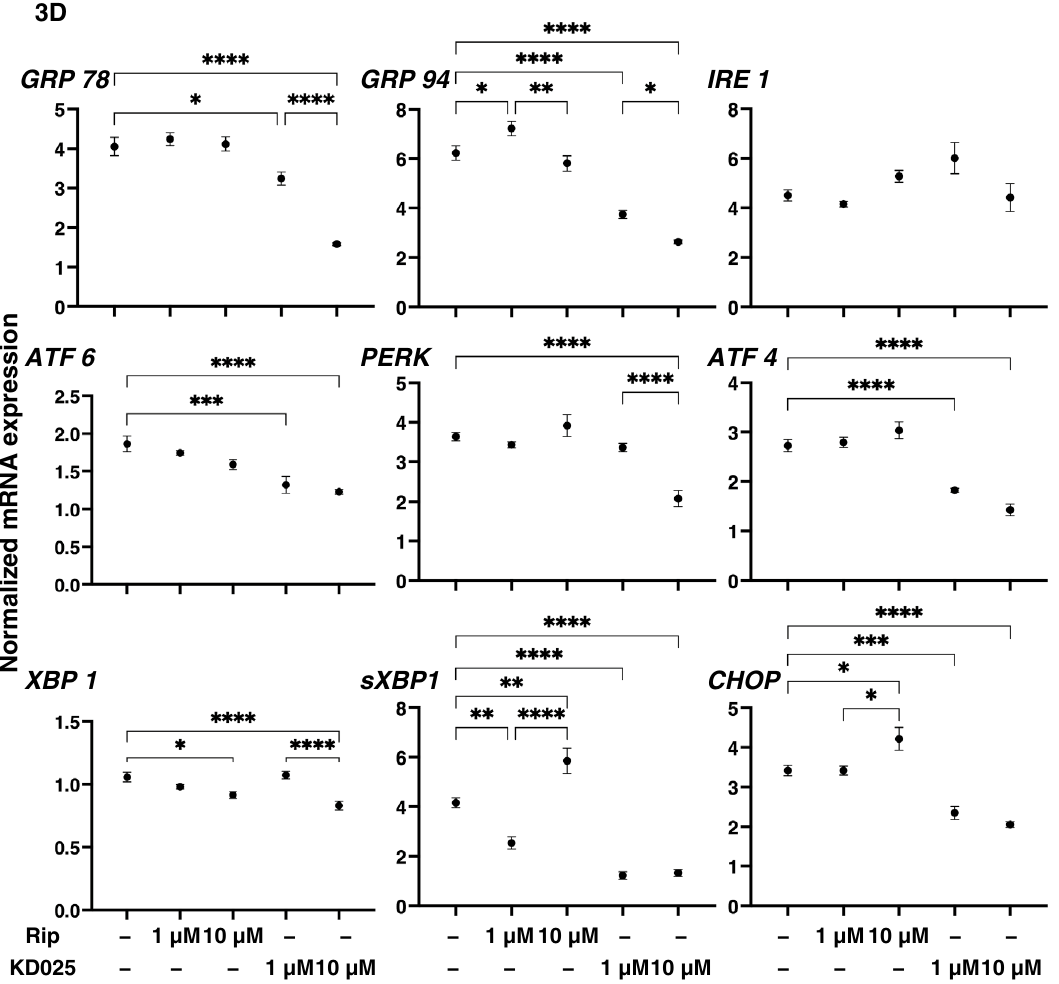
Figure 6. Effects of ROCK-is on the mRNA expression of major ER stress related genes in 3D human corneal stroma fibroblasts (HCSFs) spheroids. In the absence or presence of 1 μM or 10 μM ROCK-is, ripasudil (Rip) or KD025, 3D HCSFs spheroids at Day 6 were subjected to qPCR analyses and the expression of mRNA of major ER stress related genes of three master regulators, i.e., protein kinase RNA-like endoplasmic reticulum kinase (PERK), activating transcription factor 6 (ATF6) and the inositol-requiring enzyme 1 (IRE1), and their downstream factors including the glucose regulator protein (GRP)78, GRP94, the X-box binding protein-1 (XBP1), spliced XBP1 (sXBP1) and CCAAT/enhancer-binding protein homologous protein (CHOP) were estimated. All experiments were performed in duplicate using fresh preparations (n = 10–15, each condition). Data are presented as the arithmetic mean ± standard error of the mean (SEM). * P < 0.05, ** P < 0.01, *** P < 0.005, **** P < 0.001 (ANOVA followed by a Tukey’s multiple comparison Fig. 6, Rip modulated GRP94, XBP1, sXBP1, and CHOP , whereas KD025 induced the down-regulation of most of ER-stress related genes except IRE1 similar to that observed in the 2D cultured HCSFs.